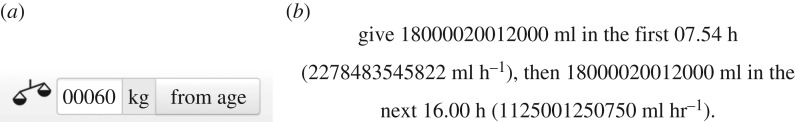
Screen shots from Mersey Burns, a multi-award winning app. The app is available from merseyburns.com. (a) Weight of patient in kilograms: apparently 60 kg is displayed; (b) calculated dose, from screen shot: the huge dose is clearly incorrect. In this example, no errors are reported by Mersey Burns so the user may act inappropriately from the advice displayed. Here, the calculated dose looks very obviously wrong (the first 7.54 h dose is over 109 l h−1, compared with an average adult blood capacity of 5 l): evidently the app does no or inadequate validation and sanity checking. More generally, less obvious errors may be missed by clinicians using this app, with potentially harmful effects. Note that Mersey Burns is used for treating burns victims—who may be in considerable pain, and whose treatment will be urgent—so what may seem obvious to us calmly reading this paper may be easily misinterpreted under real clinical conditions. Screen shots taken in November 2016.